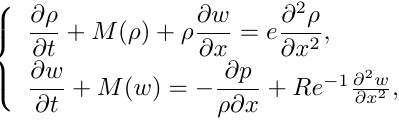
Figure 10. Minimum concentration of propane vs. t at t f